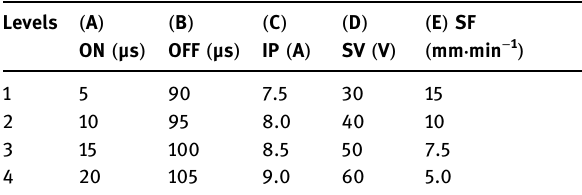
Table 3: Orthogonal test schemes of L 16 ( 4 5